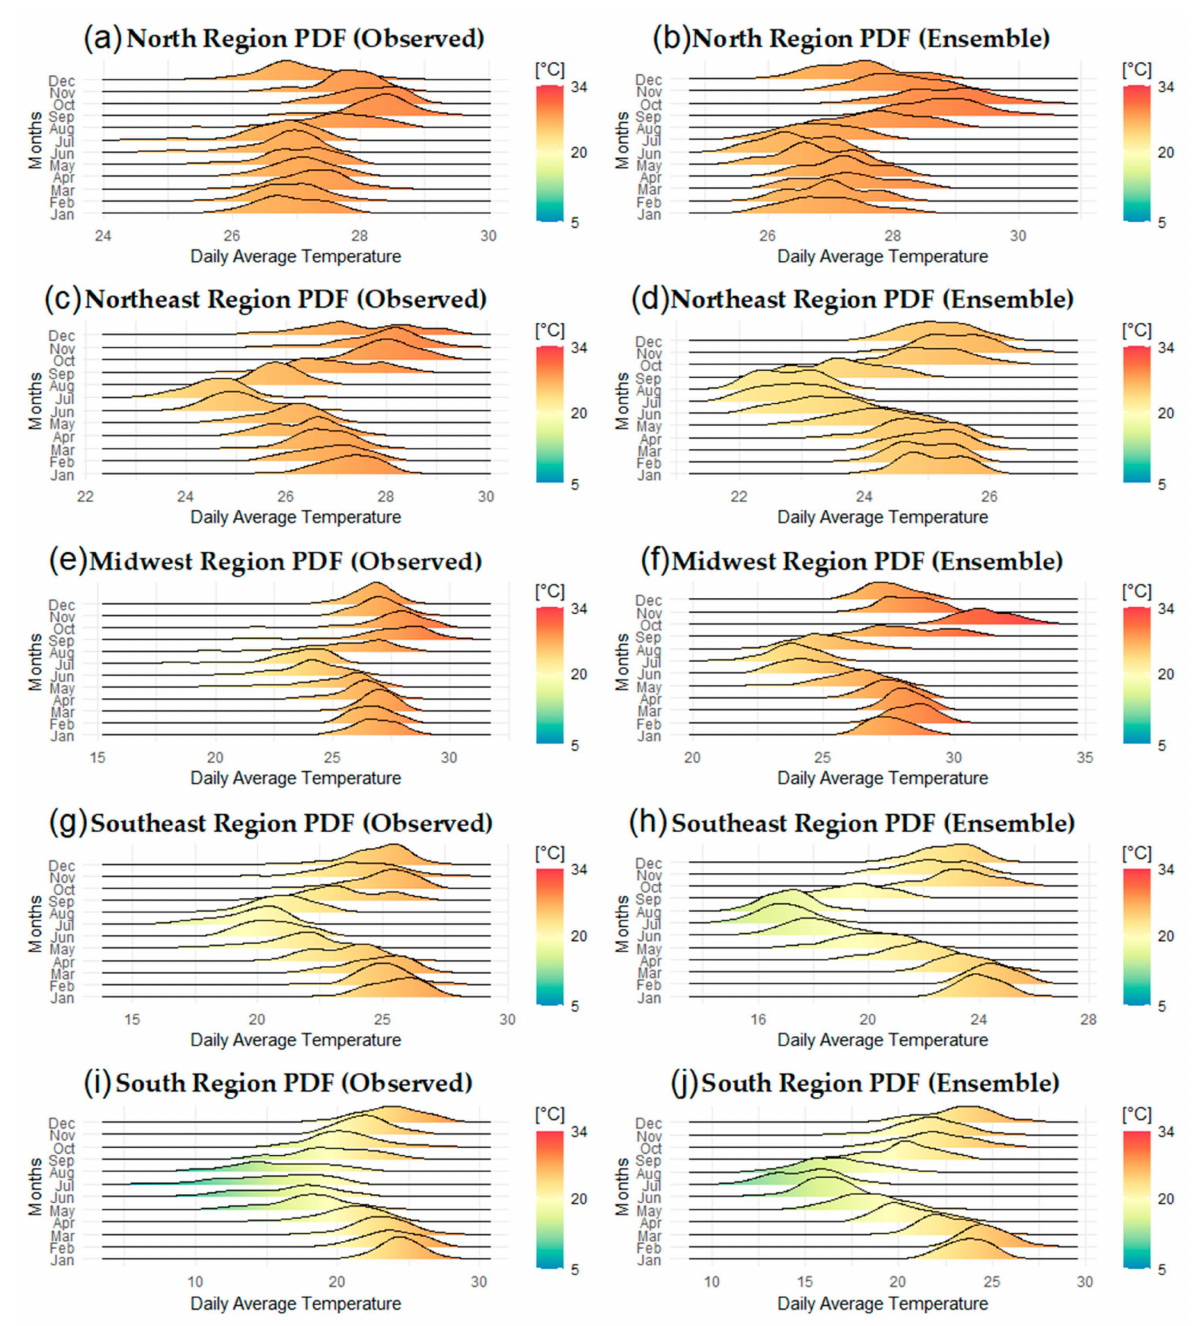
Figure 13. Mean temperature probability density ( ◦ C), with observed data on the left and BAM data on the right, for each Brazilian region: NO ( a , b ), NE ( c , d ), CO ( e , f ), SE ( g , h ), and S ( i , j